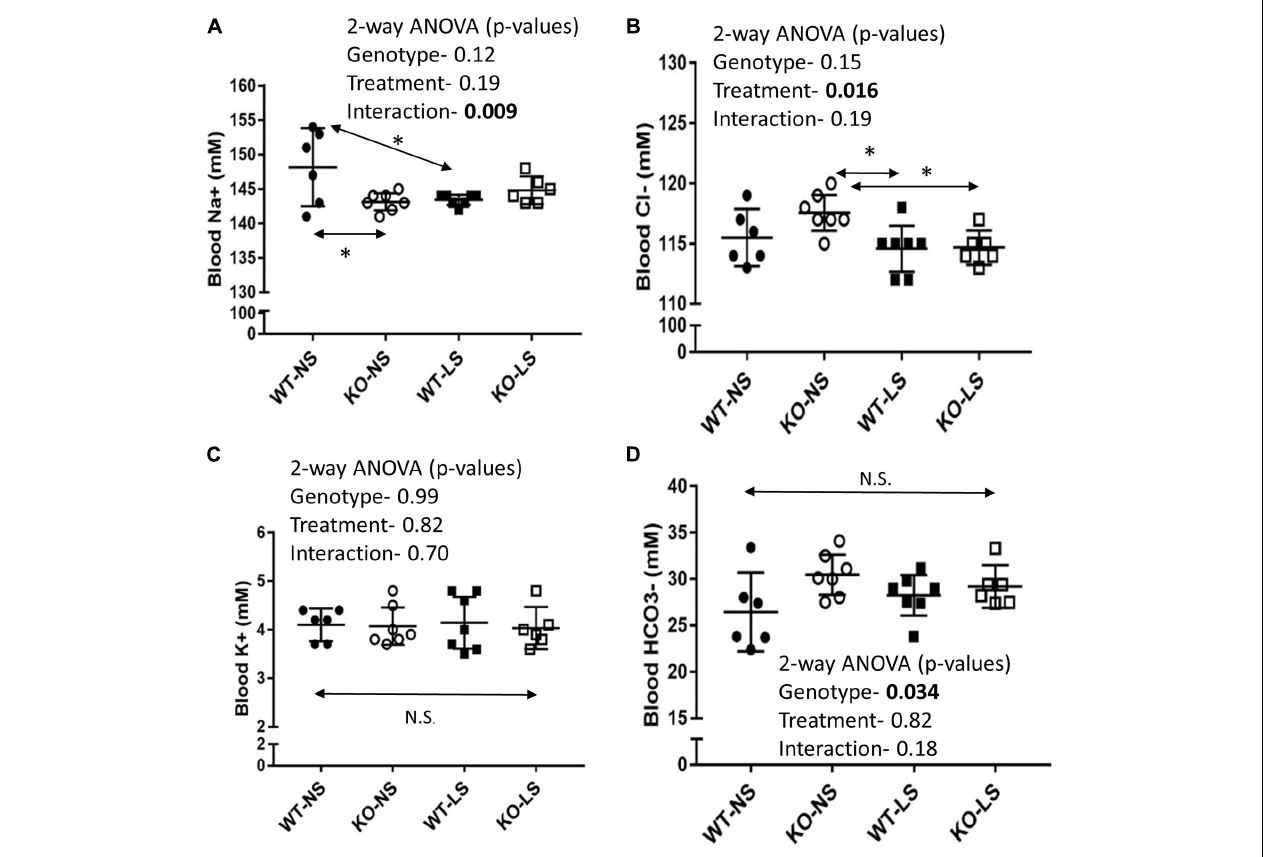
FIGURE 9 | Blood chemistry under normal and low-Na+ diet- Blood chemistry was performed by iSTAT after 7-days of NS or LS diet. (A) Na+, (B) Cl − , (C) K+, (D) HCO 3 − ( n = 6 mice/group). Two-way ANOVA p -values are shown within the panels. KO mice has reduced blood Na+ under NS, but not LS diet. LS reduced blood Cl − in both genotypes. No effects on blood K+ were noted. KO mice had significantly higher blood HCO 3 − under both diets. ∗ indicates a significant ( p < 0.05) difference between groups.